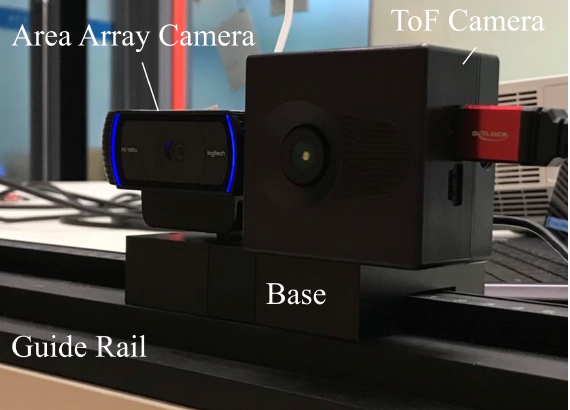
Figure 10. Appliances for the hardware-in-loop experiment.